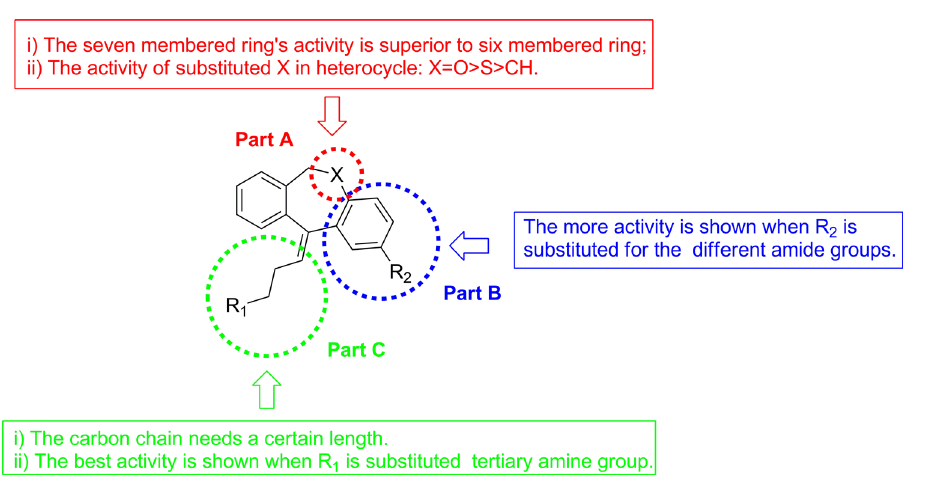
Figure 10. Regions subjected to separate SAR